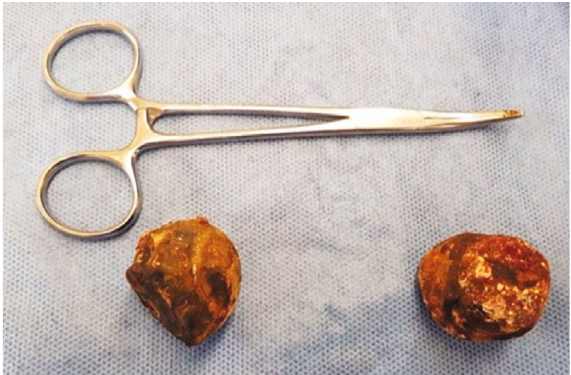
Figure 3: Two gall stones (left, 3cm, and right, 3.3cm) extracted from the proximal duodenum and sigmoid colon,